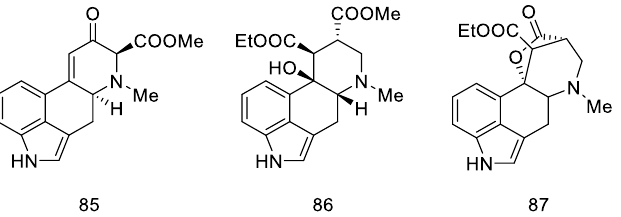
Figure 12. Structural formulas of compounds obtained in further works of Szantay ’ s research